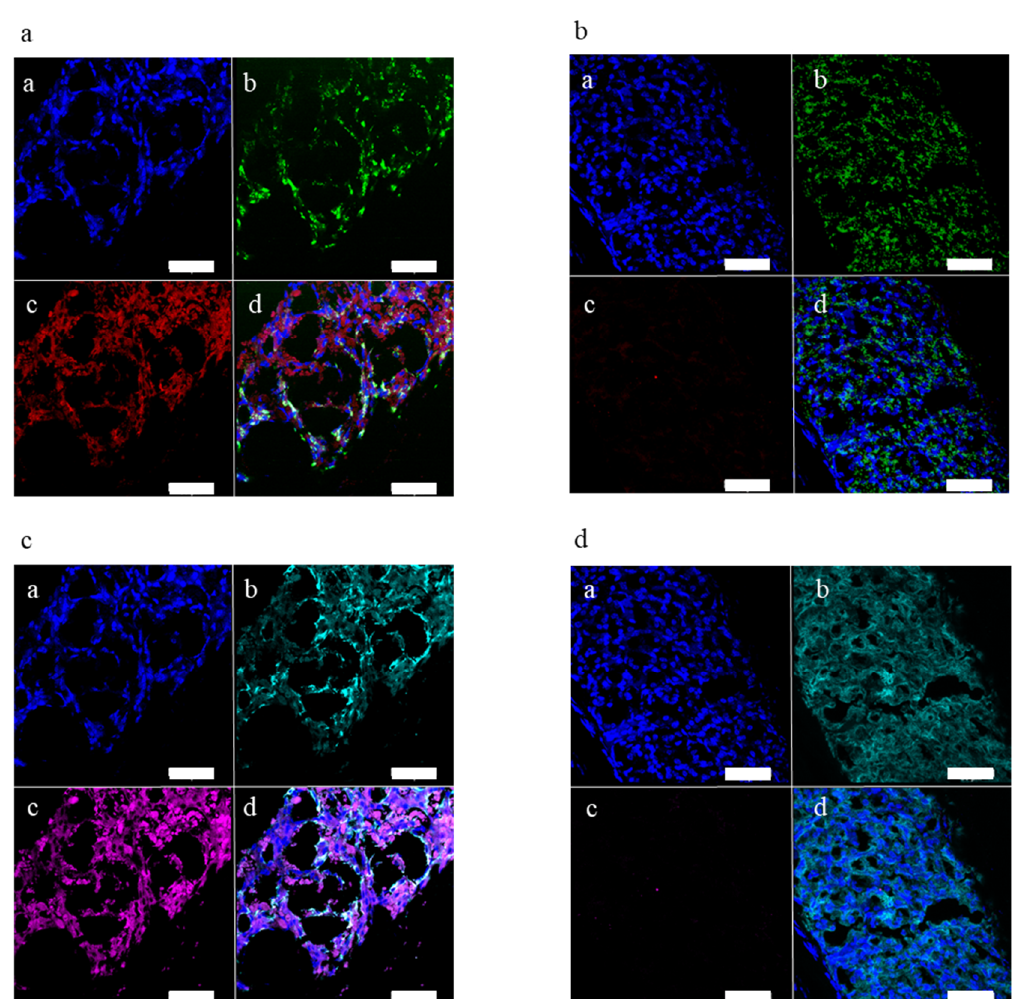
Figure 4. Characterization of leptin-expressing islet organoid grafts from animals treated with doxycycline, removed at the end of the experiment. ( a ) Fluorescent microscopy image of a leptin-expressing islet organoid graft from transplanted non-doxycycline-treated animal; ( aa ) DAPI staining; ( ab ) ZsGreen fluorescence; ( ac ) mCherry fluorescence; ( ad ) overlay. ( b ) Fluorescent microscopy image of a leptin-expressing islet organoid graft from transplanted doxycycline-treated animal; ( ba ) DAPI staining, ( bb ) ZsGreen fluorescence, ( bc ) mCherry fluorescence, ( bd ) overlay. ( c ) Immunohistochemistry image of a leptin-expressing islet organoid graft from transplanted non-doxycycline treated animal; ( ca ) DAPI staining, ( cb ) C-peptide staining, ( cc ) leptin staining, ( cd ) overlay. ( d ) Immunohistochemistry image of a leptin-expressing islet organoid graft from transplanted doxycycline treated animal; ( da ) DAPI staining, ( db ) C-peptide staining, ( dc ) leptin staining, ( dd ) overlay. ( a – d ) All scale bars 50 µm.